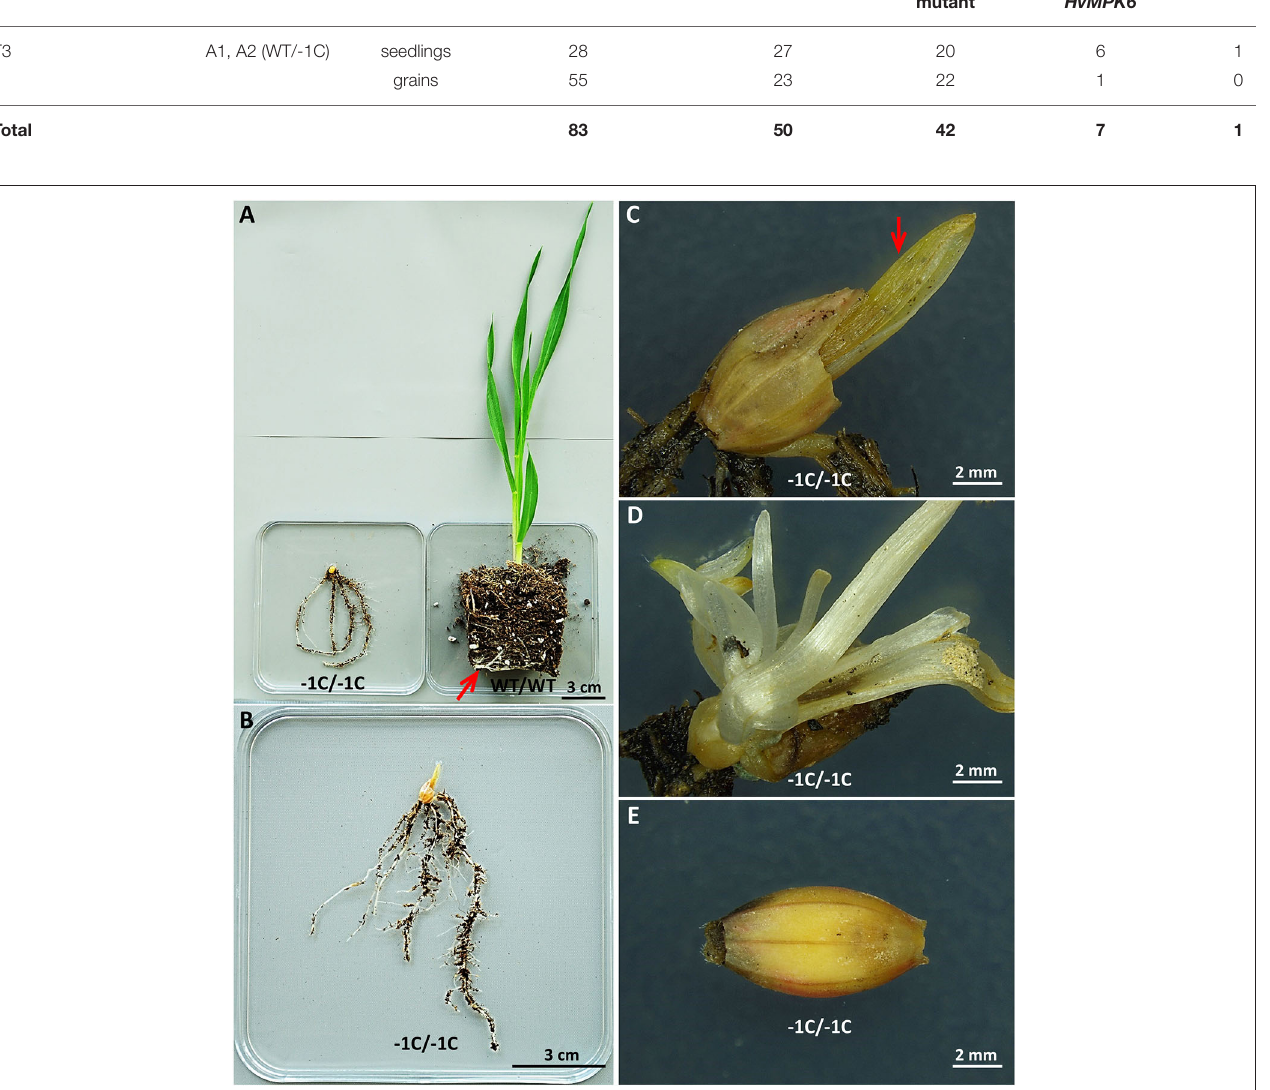
FIGURE 6 | Aberrant phenotypes of the Hvmpk6 knockout mutant ( − 1C/ − 1C) seedlings and grains. (A) A mutant ( − 1C/ − 1C) seedling and a control WT seedling (WT/WT). The mutant is shootless and has a short root system. Note that the root system of WT is longer than that of the mutant since some of the roots of WT were circling inside the pot (indicated with a red arrow). (B) A detailed view of the whole − 1C/ − 1C seedling. (C) A detailed view of the grain husk leftover and a small chlorotic leaf blade-like structure (red arrow) of the same seedling. (D) A detailed view of multiple small leaf blade-like structures of another − 1C/ − 1C seedling. (E) The majority of the − 1C/ − 1C grains did not germinate in the soil. Mutant and control WT seedlings and mutant grains were removed from the soil 3 weeks after sowing and immediately imaged.